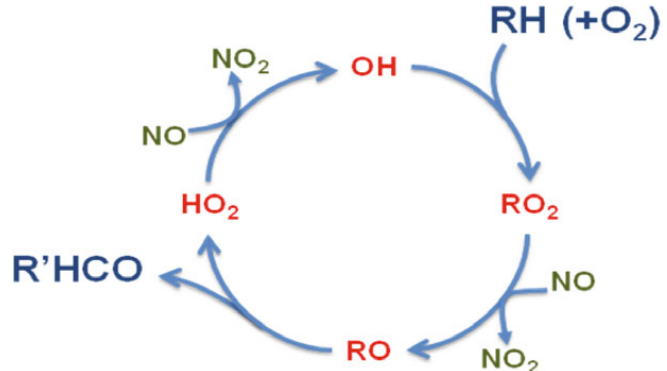
Fig. 1. Oxidation scheme for transformation of an alkane (RH) to a carbonyl (R’HCO). radicals [4], RO in Fig. 1) or co-products that are not commercially available or easy to